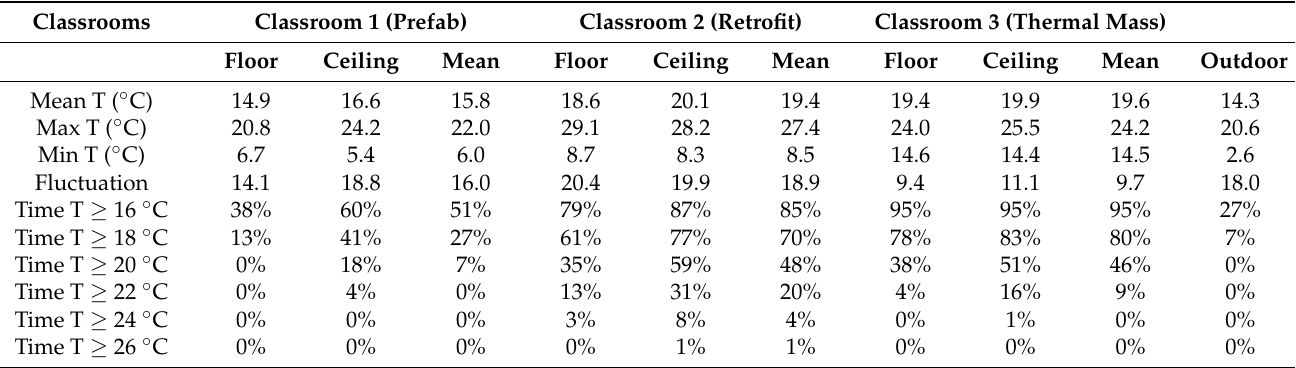
Table 3. Indoor temperatures and percentages of time related to different temperature ranges during winter school hours (from 8:30 a.m. to 3:30